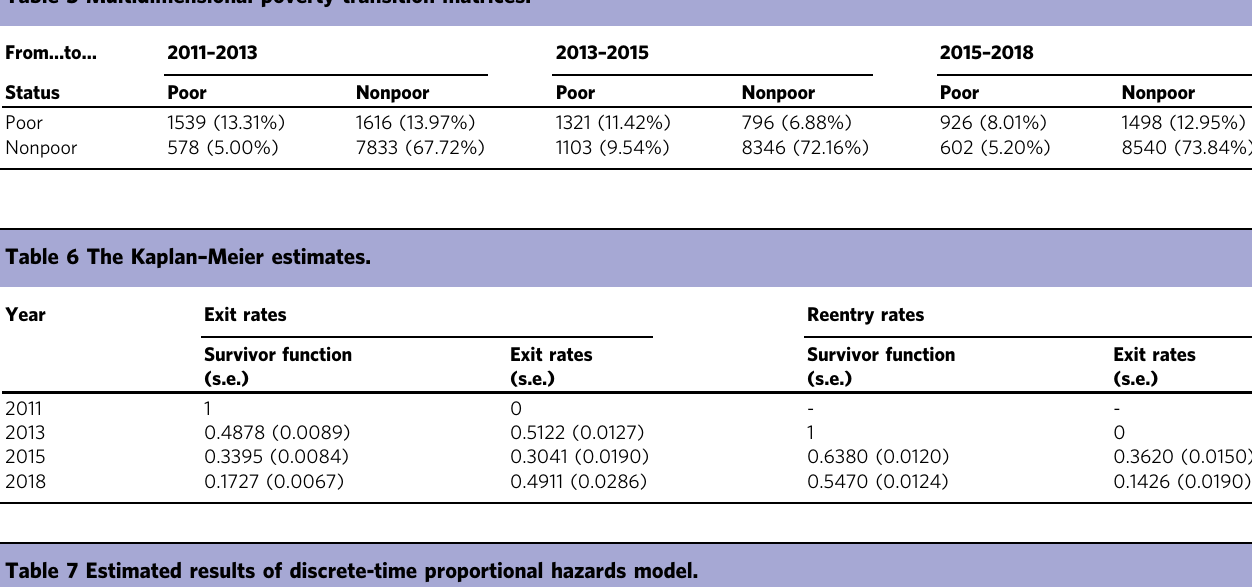
Table 5 Multidimensional poverty transition